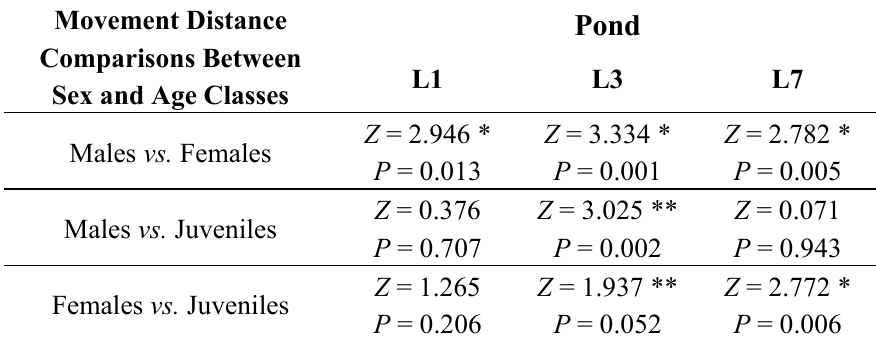
Table 2. Movement distance comparisons between sex and age classes of eastern tiger salamanders at Brookhaven National Laboratory, Long Island, New York, USA from 2005–2008. Bold indicates significance, * denotes females moving significantly farther and ** denotes juveniles moving significantly farther. Movement Distance Pond Comparisons Between L1 L3 L7 Sex and Age Classes Z = 2.946 * Z = 3.334 * Z = 2.782 * Males vs. Females P = 0.013 P = 0.001 P = 0.005 Z = 0.376 Z = 3.025 ** Z = 0.071 Males vs. Juveniles P = 0.707 P = 0.002 P = 0.943 Z = 1.265 Z = 1.937 ** Z = 2.772 * Females vs. Juveniles P = 0.206 P = 0.052 P =